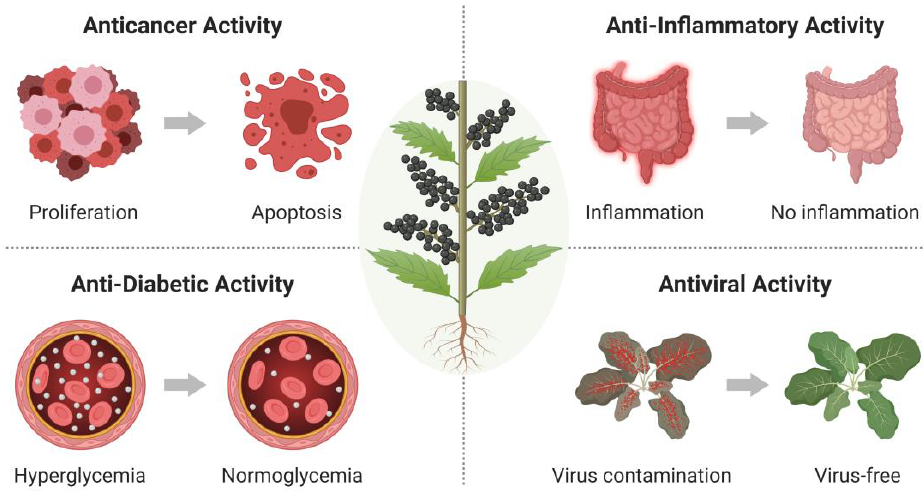
Figure 2. Schematic illustrations of four representative medicinal activities of BJO.